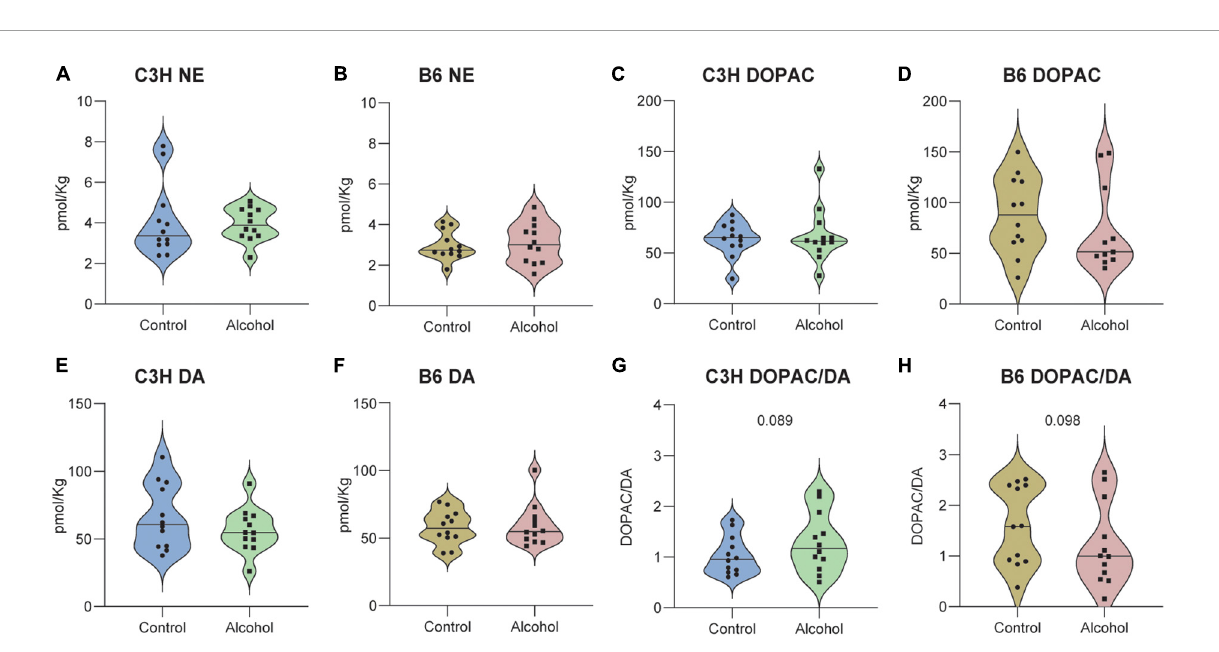
FIGURE11 Neurotransmitter levels following alcohol exposure in the striatum of C3H and B6 mice. The levels of norepinephrine (NE) (A,B) , DOPAC (C,D) , DA (E,F) , and DOPAC/DA (G,H) in the striatum of C3H and B6 mice. Data are shown as individual subjects with violin plots. n = 11–12 per